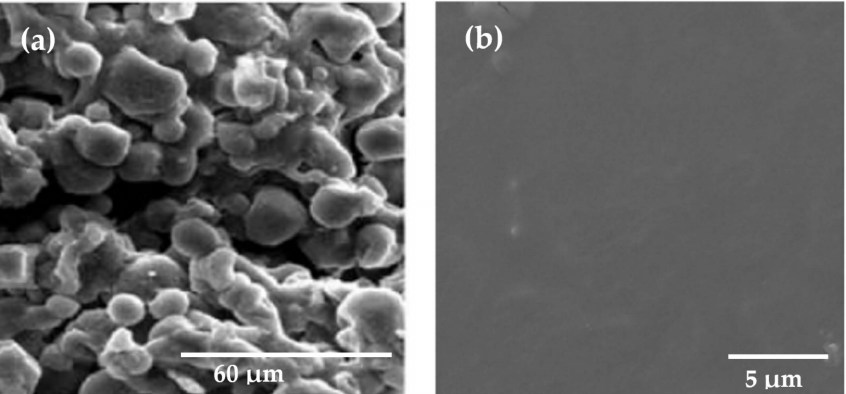
Figure 4. ( a ) SEM representation of native granular starch. Reproduced with permission from Polym. Environ., 17 , Ren et al., Study on biodegradable starch/OMMT nanocomposites for packaging applica- tions, 203–207, 2009 [53]. ( b ) SEM representation of thermoplastic starch. Reproduced with permission from Fibers, 6 , Asrofi et al., Mechanical properties of a water hyacinth nanofiber cellulose-reinforced thermoplastic starch bionanocomposite: Effect of ultrasonic vibration during processing, 1–9, 2018 [101]. TPS preparation differs based on starch source and final product usage, but it